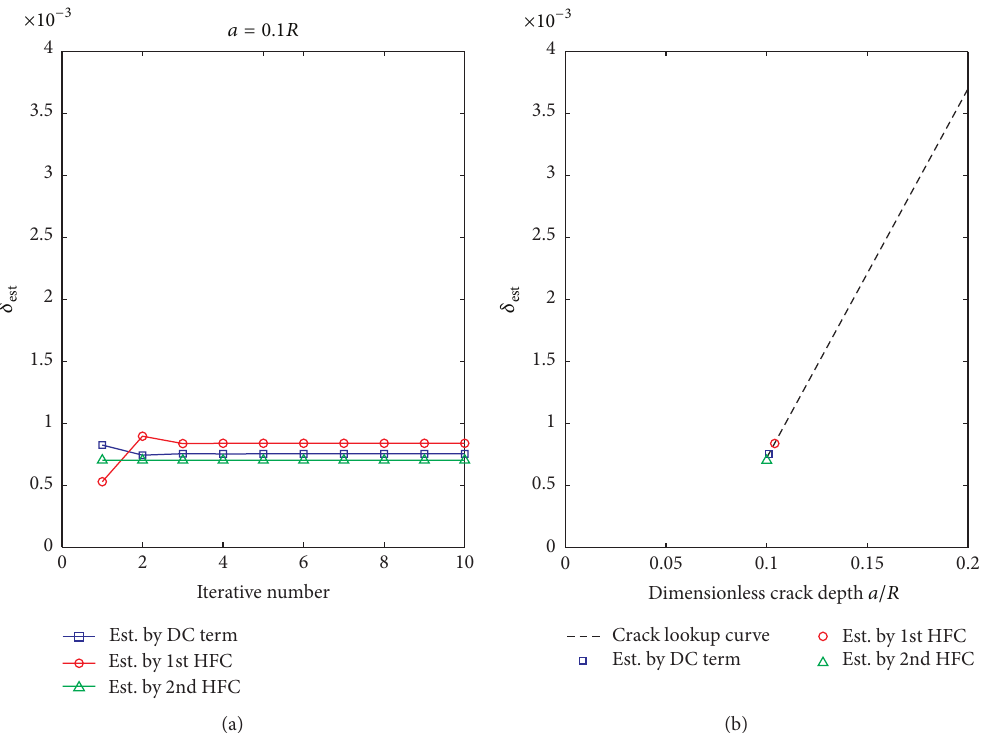
Figure 7: Damage parameter estimation for crack 𝑎 = 0.1𝑅 : (a) damage estimates iteration; (b) correlation between damage estimates and crack